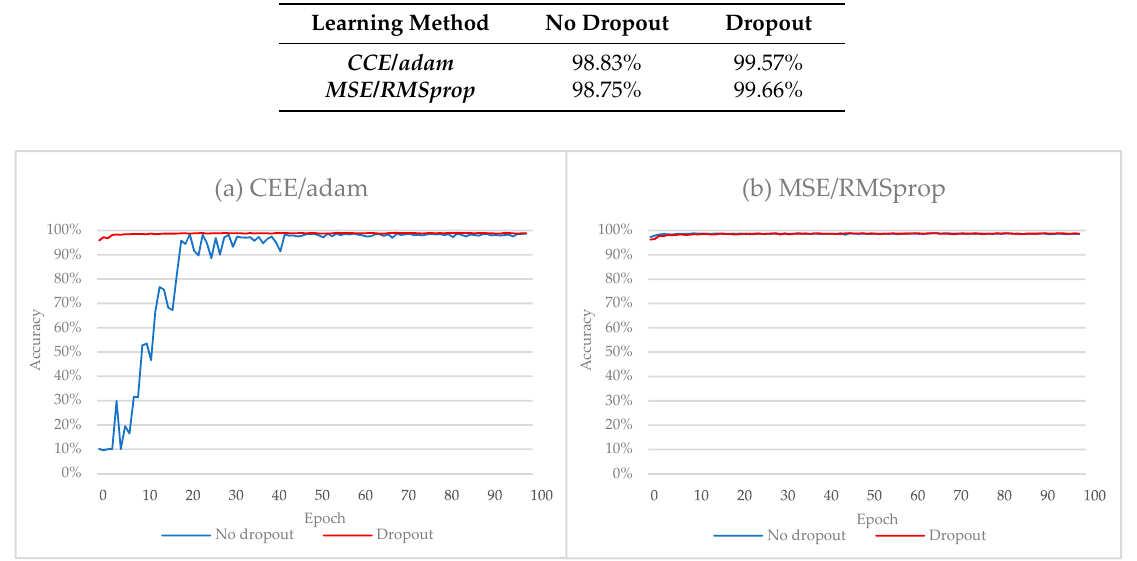
Figure 6. The performance of Alphanumeric VGG net over the ADBase database using different error criteria. ( a ) CEE/adam; ( b ) MSE/RMSprop.